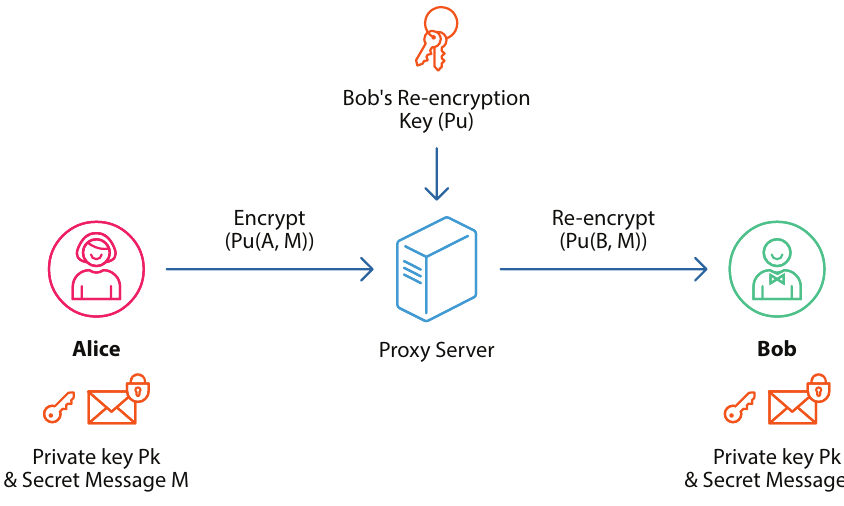
Figure 2. Overview of proxy re-encryption